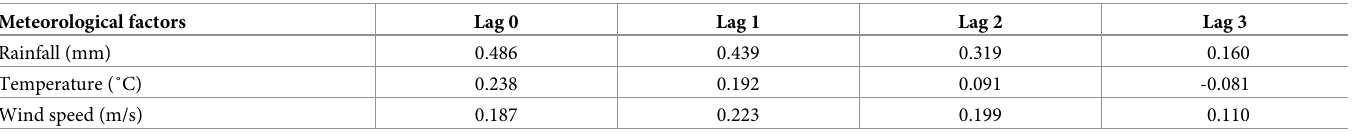
The meteorological data is first standardized. The multiplex collinear test [27] is deter- ffiffiffiffiffiffiffiffiffiffiffiffiffiffiffiffiffiffi p mined by the condition number K ¼ l = l , where λ is the eigenvalues of independent max min variable matrix. Since K = 1.97 < 15, there is no significant correlation between meteorological factors. Let μ be the number of cases, and X , X and X be the monthly average tempera- ik i 1 k i 2 k i 3 k ture, rainfall and wind speed in the k th month at the i th region. The GWPR model is formed by ð m Þ ¼ b ð u ; v Þ þ b ð u ; v Þ X þ b ð u ; v Þ X þ b ð u ; v Þ X ð 3 Þ g 1 0 1 2 3 ik ik ik ik ik i 1 k ik ik i 2 k ik ik i 3 k for j = 1, 2, 3, i = 1, . . . , n and n = 15, where k is a fixed constant taken from {1, 2, . . . , m } and m = 120. The GTWPR model is established as follows ð m Þ ¼ b ð u ; v ; t Þ þ b ð u ; v ; t Þ X þ b ð u ; v ; t Þ X g 2 0 k 1 k 2 k ik ik ik k ik ik k i 1 k ik ik k i 2 k ð 4 Þ þ b ð u ; v ; t Þ X ; k ¼ 1 ; . . . ; m ; 3 k ik ik k i 3 k where other parameters are the same as above. The estimated coefficients ^ b ð u ; v Þ and j ik ik ^ b ð u ; v ; t Þ can be obtained by the weighted least square method and local linear geographi- jk ik ik k cal weighted regression. The performance of two models are investigated by the coefficient of determination R 2 , Akaike information criterion (AIC), deviation (D) and mean squared error (MSE) in Table 4. It reveals that R 2 increases from 0.633 in the GWPR model to 0.915 in the GTWPR model. The values of AIC, D and MSE in GTWPR model are smaller than GWPR model. Thus, GTWPR model is more suitable and effective to analyze the spatiotemporal HFM disease than GWPR model.